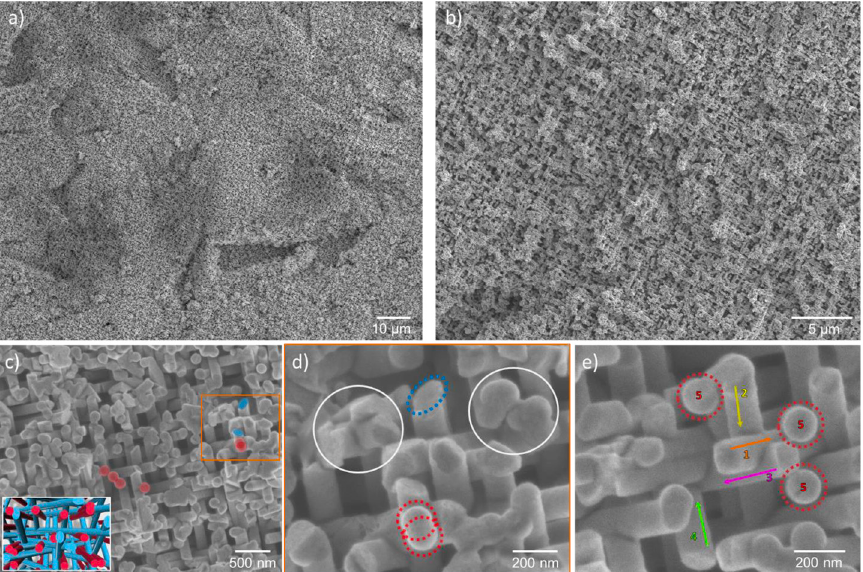
Figure 3. SEM images of a representative nanowire network with wire diameter ~150 nm and density ~5 × 10 9 wires/cm 2 at ( a ) low and ( b , c ) high magnification. The inset in ( c ) shows a 3D illustration of the top view of the network with wires tilted (blue) and perpendicular (red) with respect to the substrate; ( d , e ) zoomed-in SEM images of the network showing intersections and wire orientations.